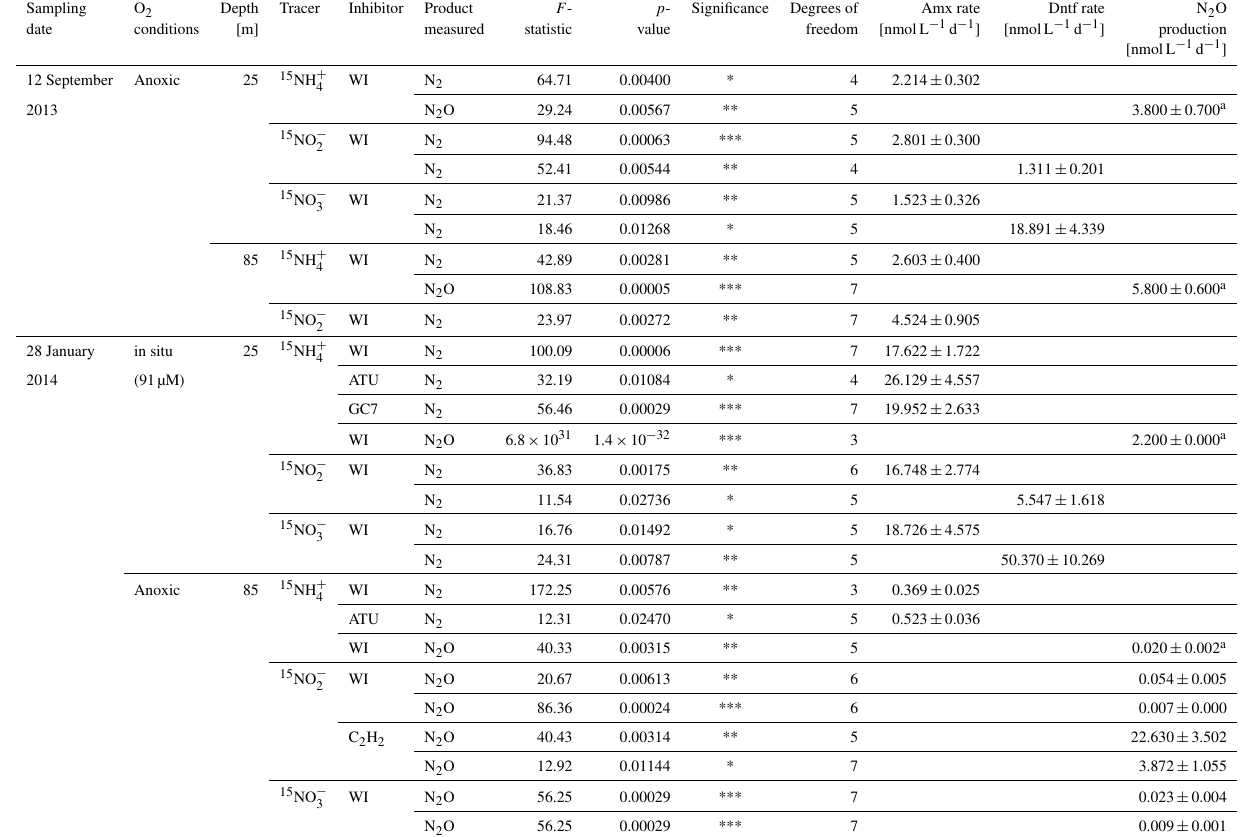
Table 2. Experimental dates, oxygen conditions during the incubations, tested depths, tracers and inhibitors amendments, measured N- gaseous specie (N 2 or N 2 O), summary of the Student’s t test used to evaluate the significance of the activity obtained, and anammox (Amx) and denitrification (Dntf)